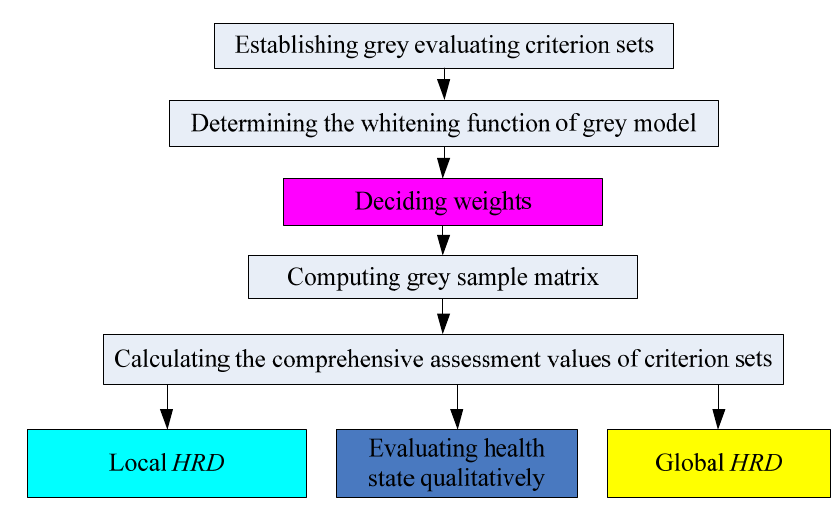
Figure 5. Flowchart of the HRD